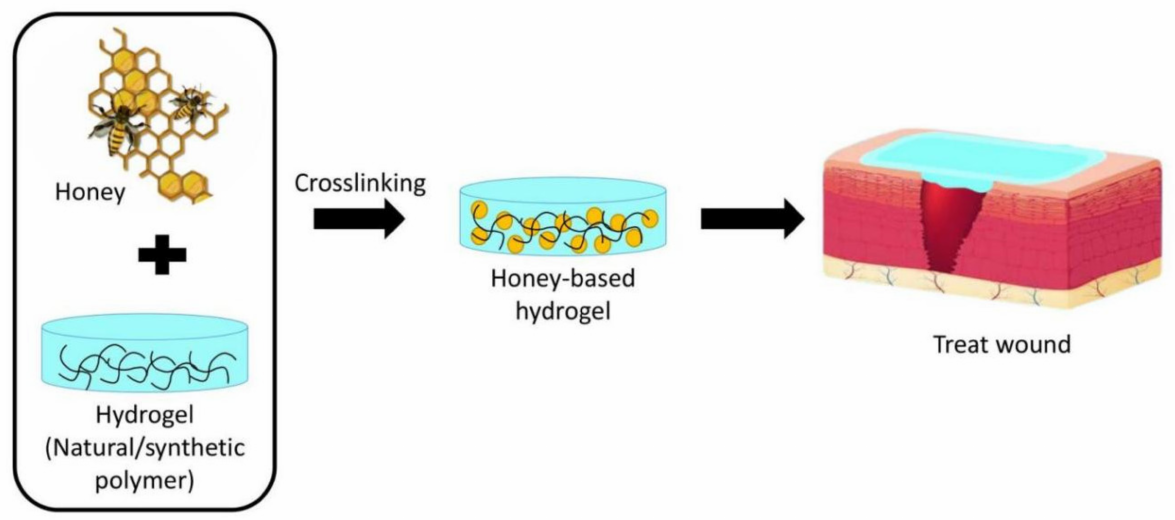
Figure 4. Schematic of honey-based